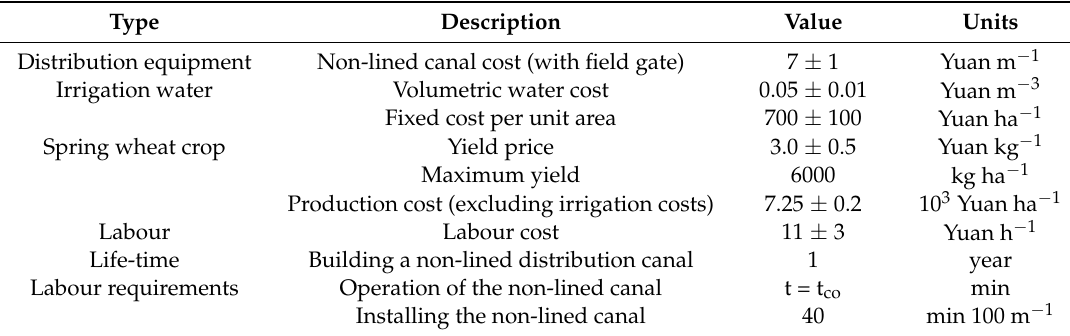
Table 6. Economic and labour input data for wheat basin